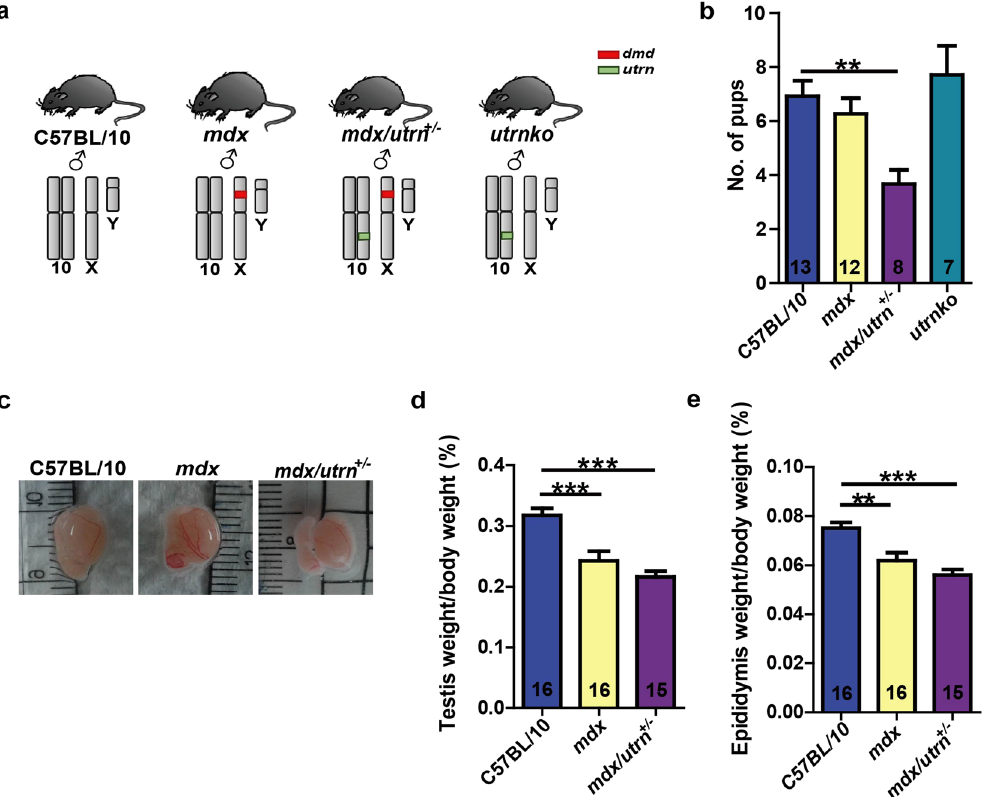
Figure 1. Dystrophin deficiency causes defects in the male reproductive organs. ( a ) The chromosome diagrams of mouse models for control (C57BL/10), dystrophin-deficiency ( mdx ), dystrophin-null/utrophin haplodeficiency ( mdx/utrn + / − ) and utrophin null ( utrnko ). The red box indicates the mutant dmd locus whereas the green box indicates the mutated utrn locus. ( b ) The litter size in C57BL1/0, mdx , mdx/utrn + / − and utrnko mice. ( c ) Average testicle size in the ten-week-old C57BL/10, mdx and mdx/utrn + / − mice . ( d ) Statistical analysis of testis size of the ten-week-old C57BL/10, mdx and mdx/utrn + / − mice. ( e ) The statistical analysis of the epididymis size of the ten-week-old C57BL/10, mdx and mdx/utrn + / − . Data were analyzed with one-way ANOVA. All values are represented as mean ± SEM. The number of mice examined was labeled on the bar charts. * compared with the C57BL/10. ** P < 0.01; *** P <